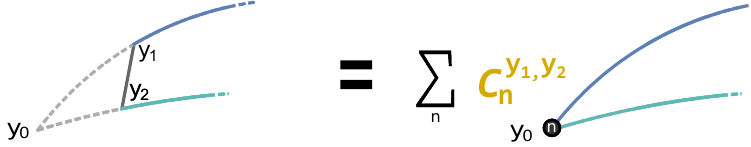
Figure 21 . Expansion of the Wilson lines starting at points y 1 , y 2 in terms of Wilson arcs emanating from y 0 , as written in equation (9.10).